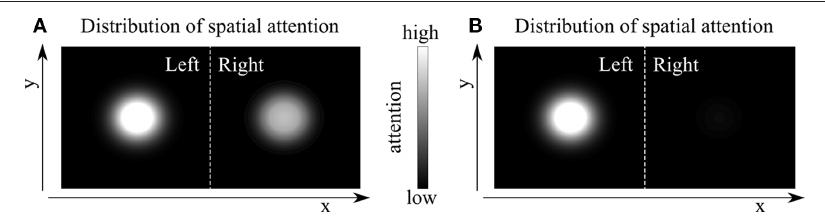
Figure 1 | Alternative distributions of spatial attention in the two hemifields. By task design, the measure of attention in Cohen and Maunsell (2010) is intrinsically relative (e.g., more attention to the left versus right hemifield). Thus, it is not possible to distinguish whether attention within the source areas is split across hemifields (A) , or instead there is a single spotlight of attention (B)